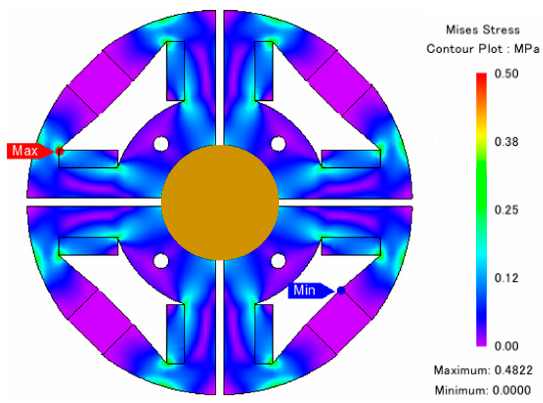
Figure 20. Mises stress distribution.